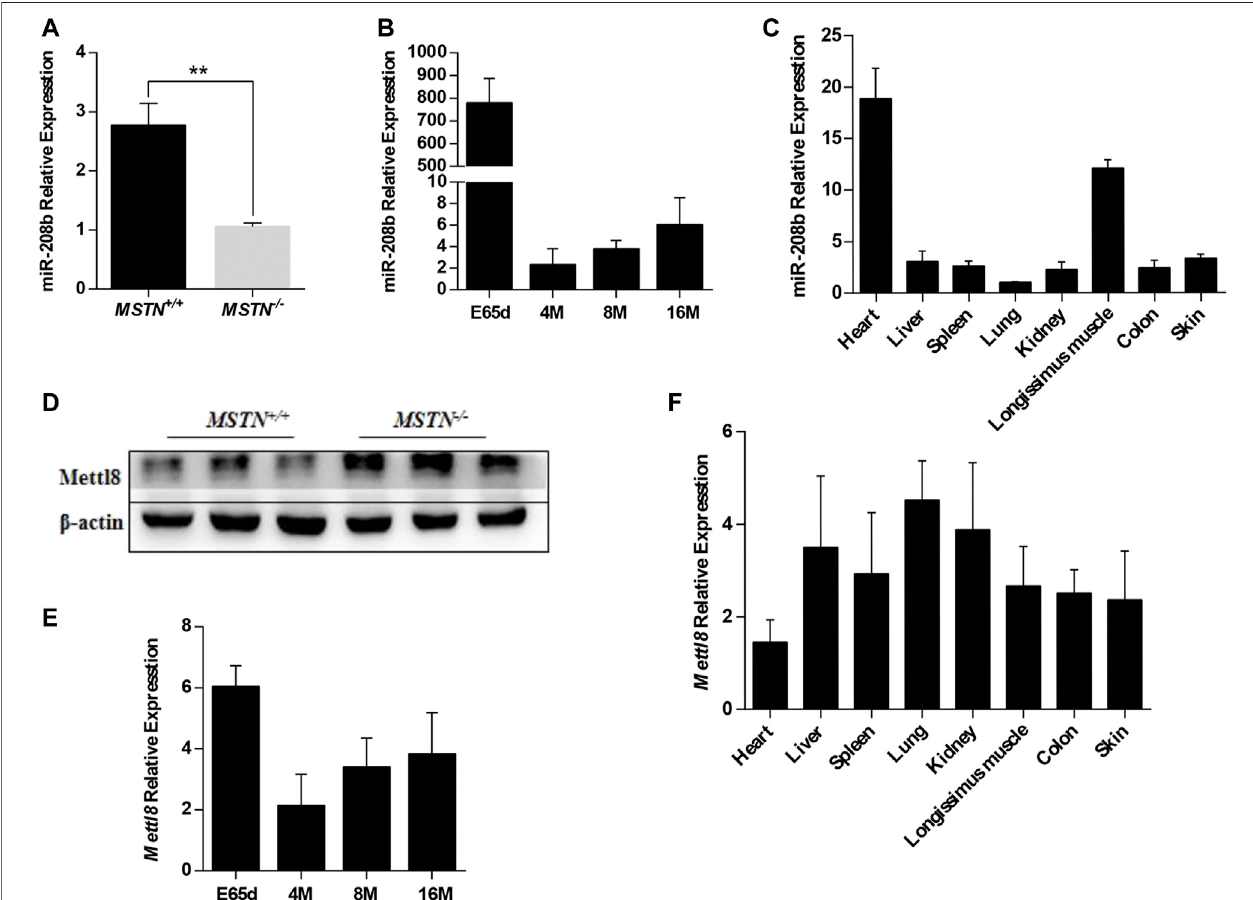
FIGURE 1 | Expression pattern of miR-208b and Mettl8 in Meishan pigs. (A) Expression level of miR-208b in the longissimus dorsi from wild type (MSTN +/+ ) and MSTN − /- MeishanpigsonE65d. (B) ExpressionlevelofmiR-208binthelongissimusdorsifromwildtype(MSTN +/+ )Meishanpigsatdifferentages. (C) Expressionlevelof miR-208b in different tissues from wild type (MSTN +/+ ) Meishan pigs on E65d. (D) Expression level of Mettl8 protein in the longissimus dorsi muscle from wild type (MSTN +/+ )and MSTN − /- MeishanpigsonE65d. (E) Expressionlevel ofMettl8protein inthelongissimusdorsi musclefrom wildtype(MSTN +/+ )at differentages. (F) Expression level of Mettl8 protein in different tissues from wild type (MSTN +/+ ) on E65. E65d means pigs on day 65 of embryonic development, 4, 8, 16 M indicate 4, 8, and16 months after birth, respectively. Statistical comparisons are performed using unpaired t -tests in (A,B) (The data of 4, 8 and 16 M are compared with the data of E65d, respectively), (E) (The data of 4, 8 and 16 M are compared with the data of E65d, respectively)and using ordinary one-way ANOVA in (C,F) . ** p <